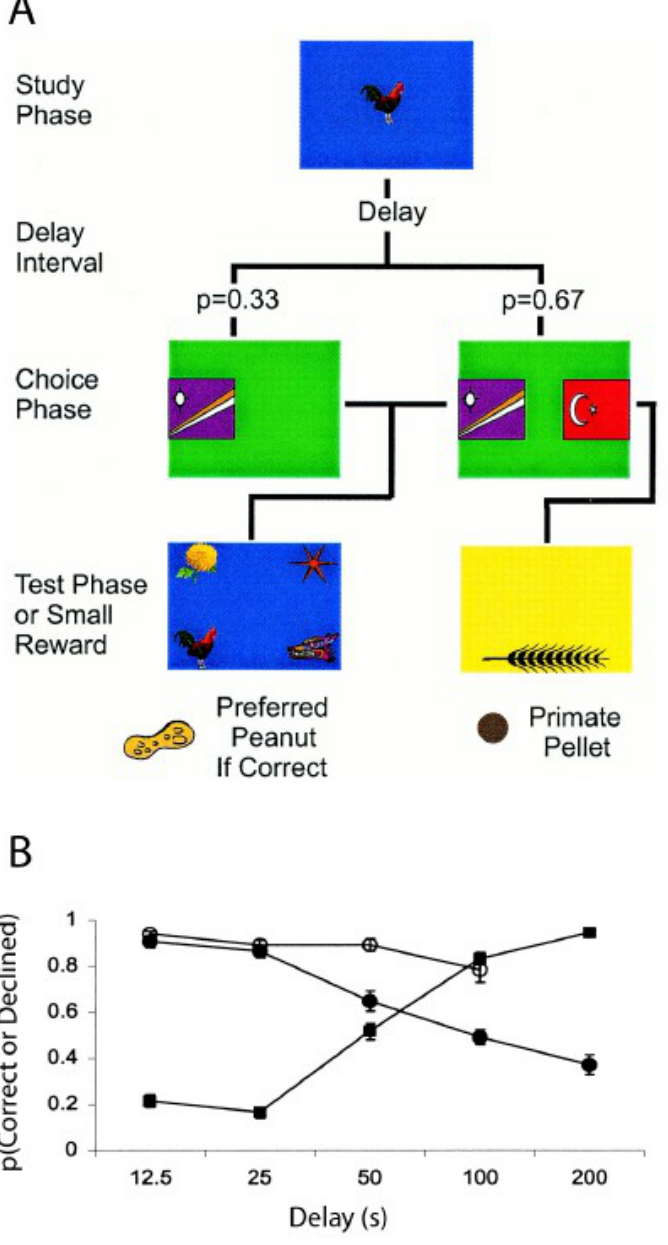
Figure 1. Schematic representation of design of study and data for monkeys. A. Procedure (top panel; Hampton, 2001): After presentation of a clip-art image to study and a retention-interval delay, a choice phase provided an opportunity for taking or declining a memory test; declining a test produced a guaranteed but less preferred reward than was earned if a test was selected and answered correctly (test phase); no food was presented when a distracter image was selected in the memory test. Items were selected by contacting a touch-sensitive computer monitor. B. Data (bottom panel; Hampton, 2001): Performance from a monkey that both used the decline response to avoid difficult problems (i.e., relatively long retention intervals) and had a chosen-forced performance advantage that emerged as a function of task difficulty (i.e., accuracy was higher on trials in which the monkey chose to take the test compared with forced tests, particularly for difficult tests). Filled squares represent the proportion of trials declined, and filled and unfilled circles represent proportion correct on forced and chosen trials, respectively. Error bars represent standard errors. (Adapted from Hampton, R. (2001). Rhesus monkeys know when they remember. Proceedings of the National Academy of Sciences of the United States of America, 98, 5359-5362. © 2001 The National Academy of Sciences. Reprinted with